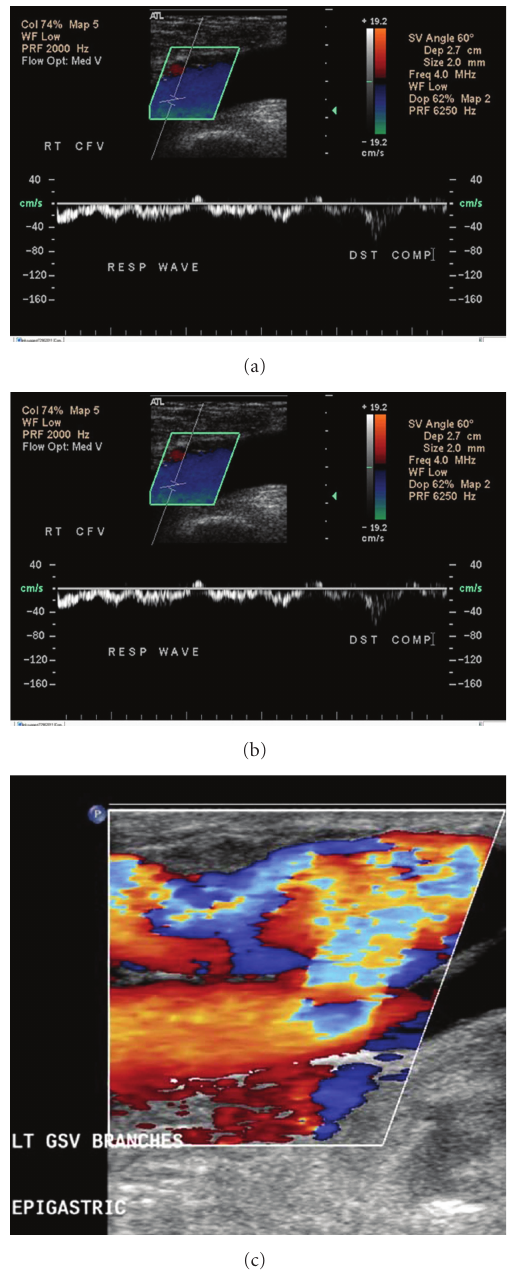
Figure 3: (a) Normal-to-high signal in the left common femoral vein 3 years before presentation. (b) Increased Doppler velocity in the left common femoral vein 1 year prior to presentation. (c) Marked turbulence and high flow at the junction of the left great saphenous vein with the femoral